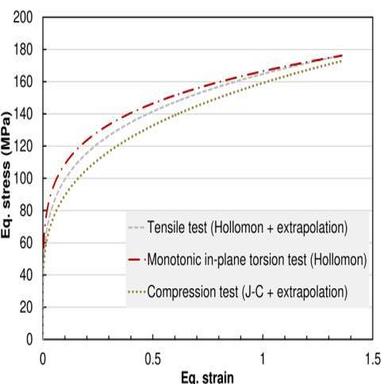
Flow formed wall of a necking configuration compared with a "safe" configuration (experimental results).